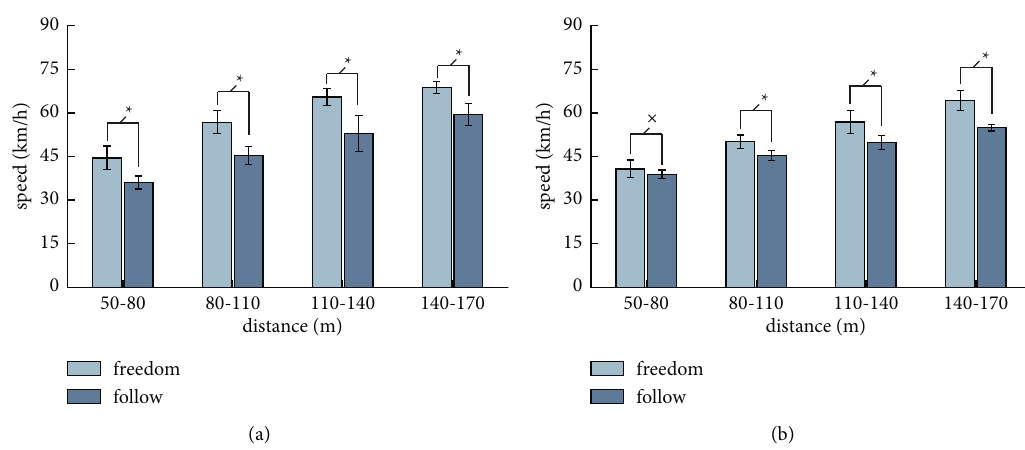
Figure 8: ANOVA results for traffic state on the first approach speed. Note : (1) error bar is 95% C.I.; (2) ∗ means significant, × means insignificant. (a) Low density; (b) high density.